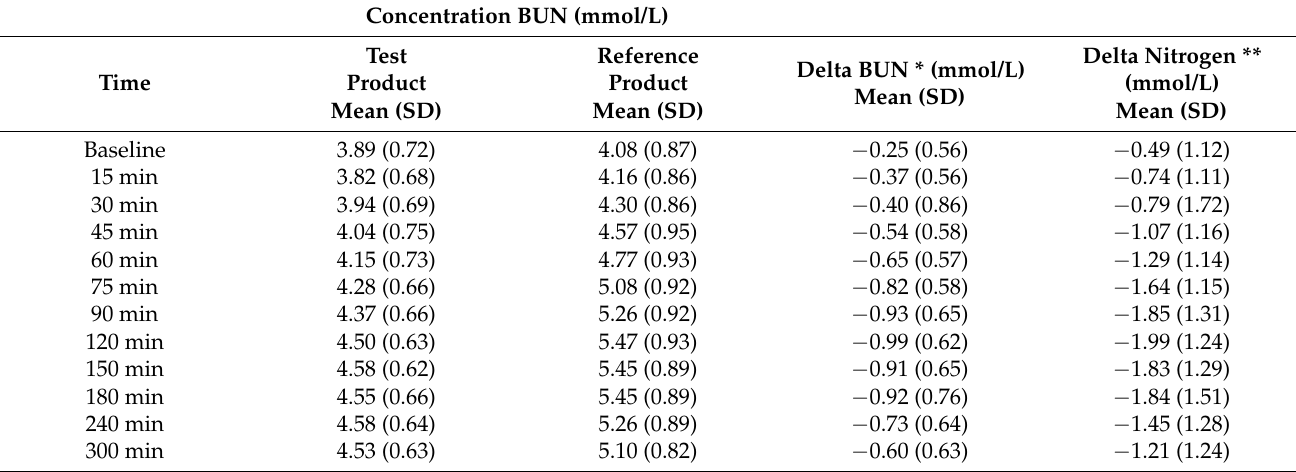
Table 2. Blood urea nitrogen concentrations after the intake of the Test product and the Reference product and Delta nitrogen content.